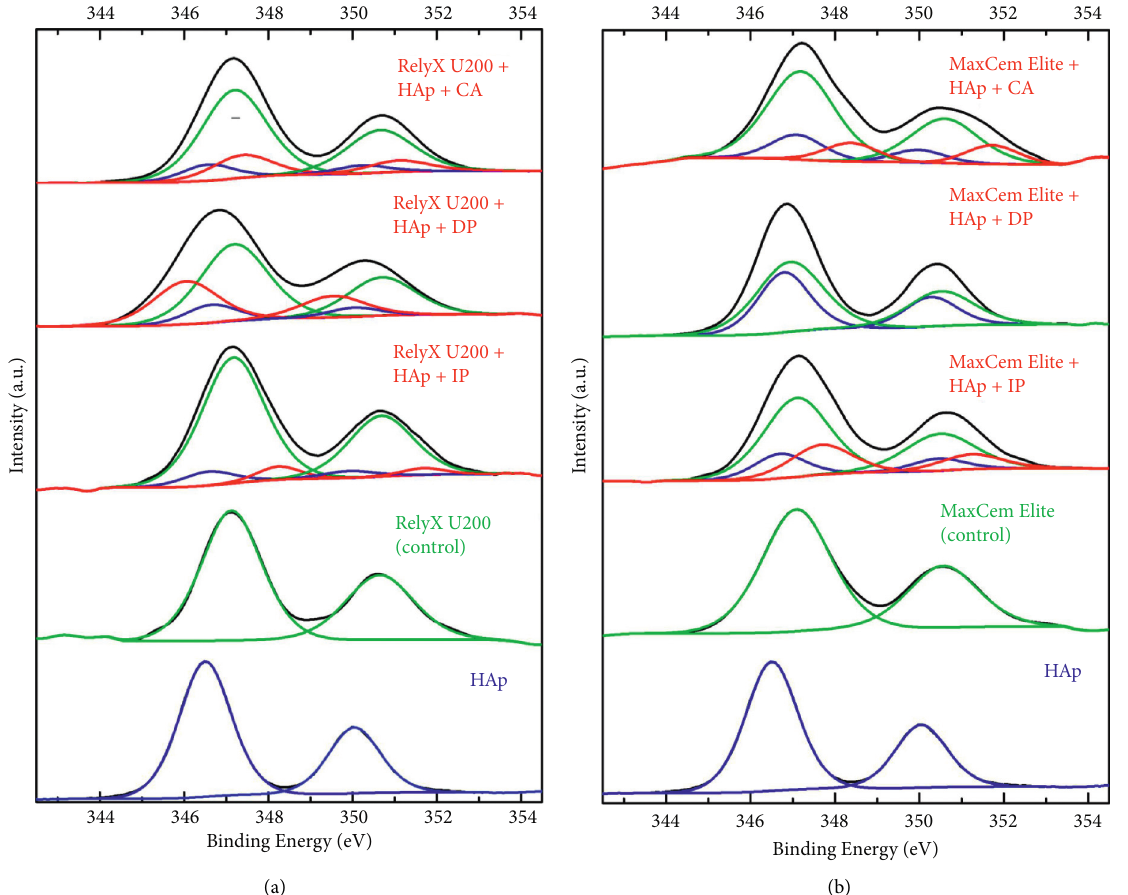
Figure 7: High-resolution Ca2p spectra of (a) RelyX U200 experimental groups and (b) Maxcem Elite experimental groups. The blue spectra are related to HAp, while those in green are associated with the resin cement spectra. The spectra in red appeared during peak deconvolution for improved